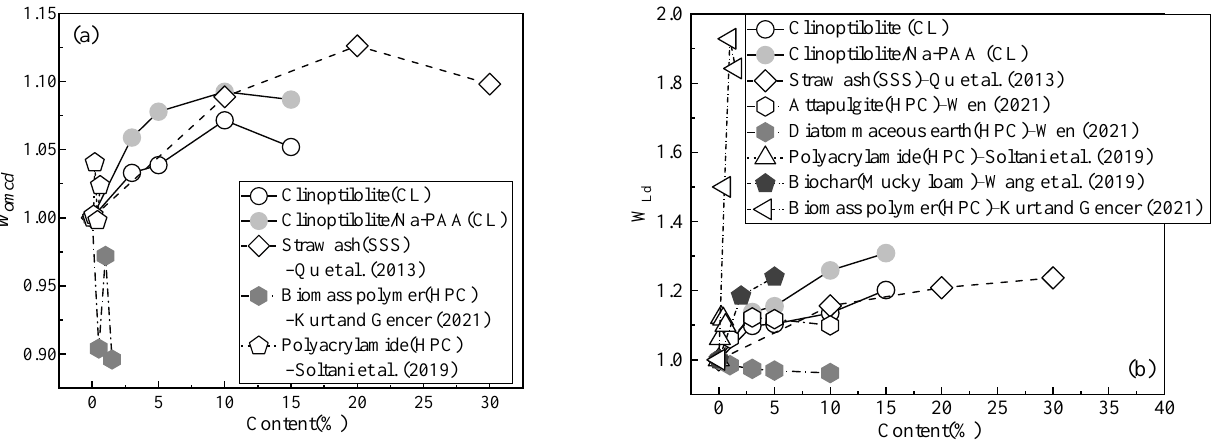
Figure 13. The influence of different water-retaining agents materials on the optimum moisture content and liquid limit. ( a ) Optimum moisture content ( w omcd ) [38,56,57], ( b ) liquid limit (W Ld ) [15,38, 56 − 58] . Table 7. Comparison of economic benefits of partial water-retaining agents.